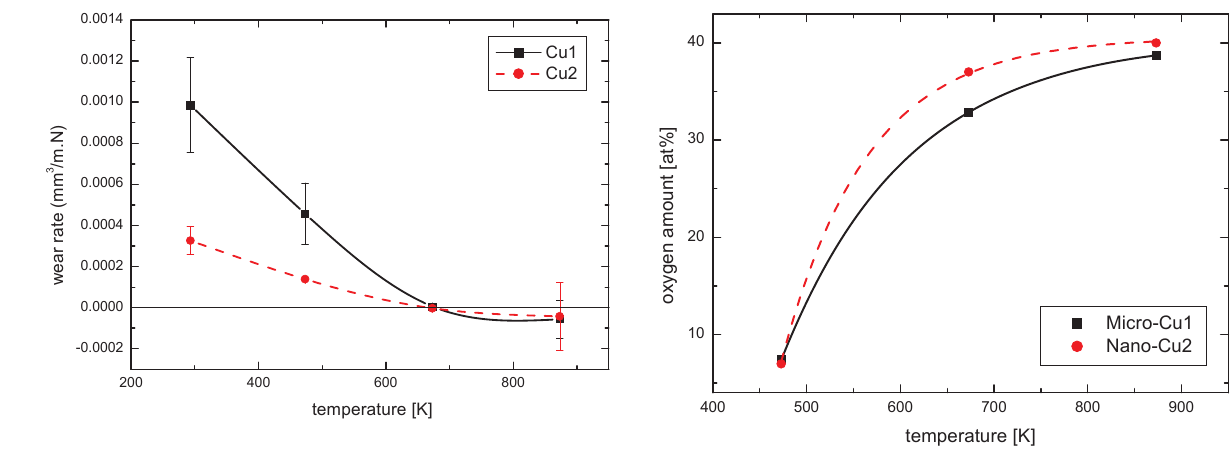
Figure 6. Temperature variance of wear rates.